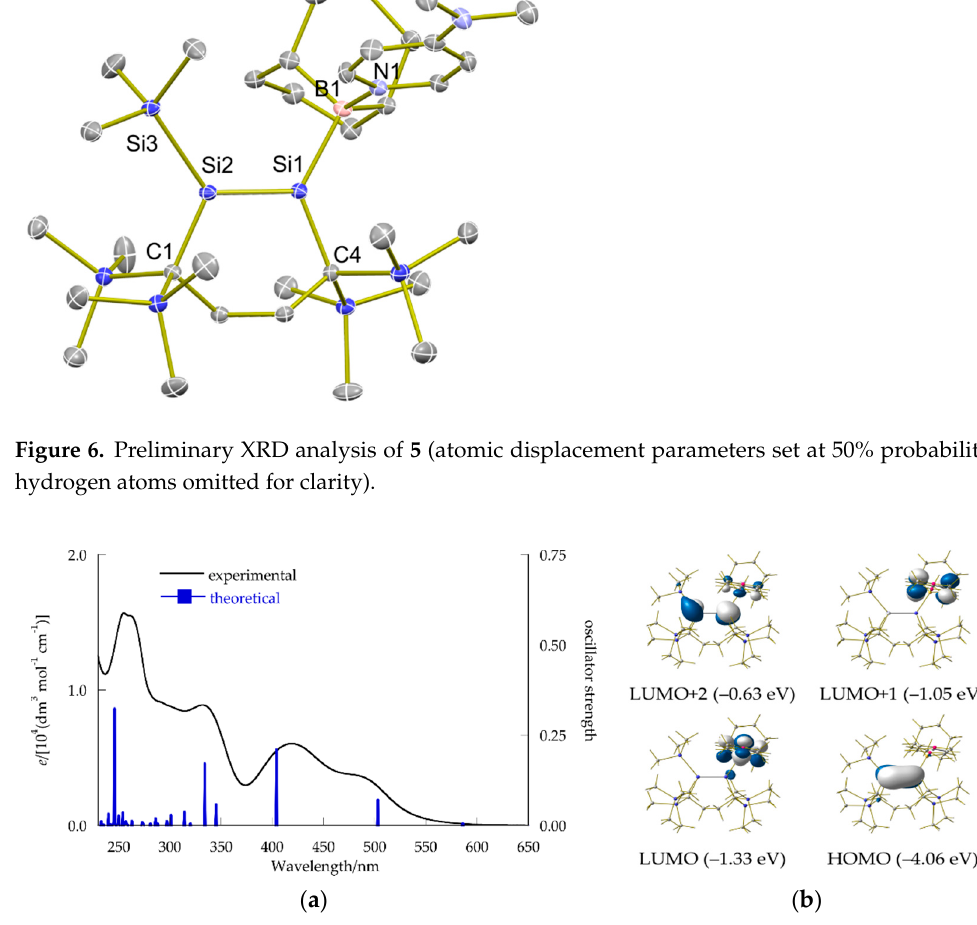
Figure 6. Preliminary XRD analysis of 5 (atomic displacement parameters set at 50% probability; hydrogen atoms omitted for clarity).